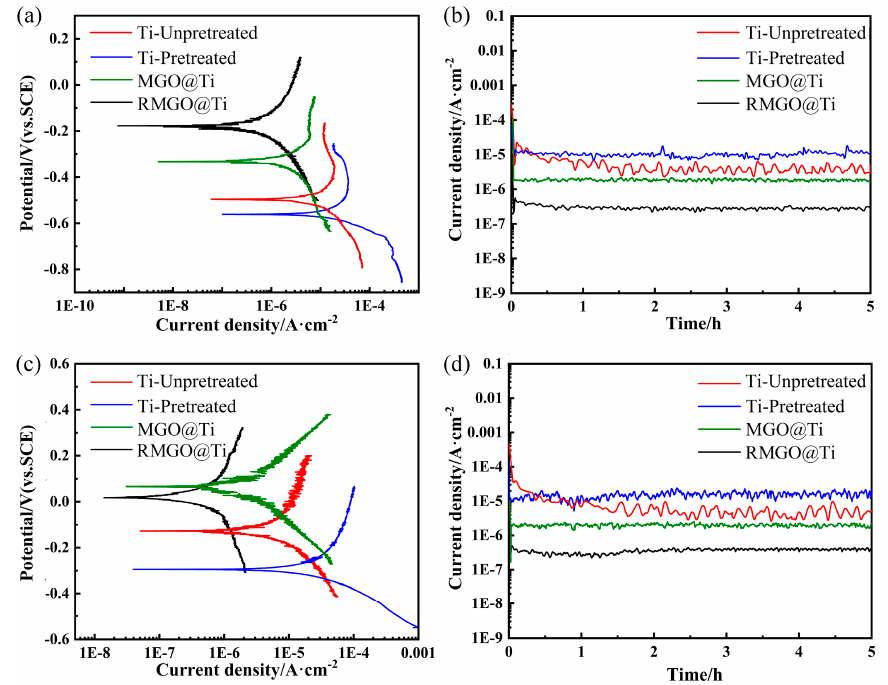
Figure 3. Electrochemical measurements curves for Ti-Unpretreated, Ti-Pretreated, MGO@Ti, and RMGO@Ti under anodic ( a , b ), and cathodic ( c , d ) conditions.